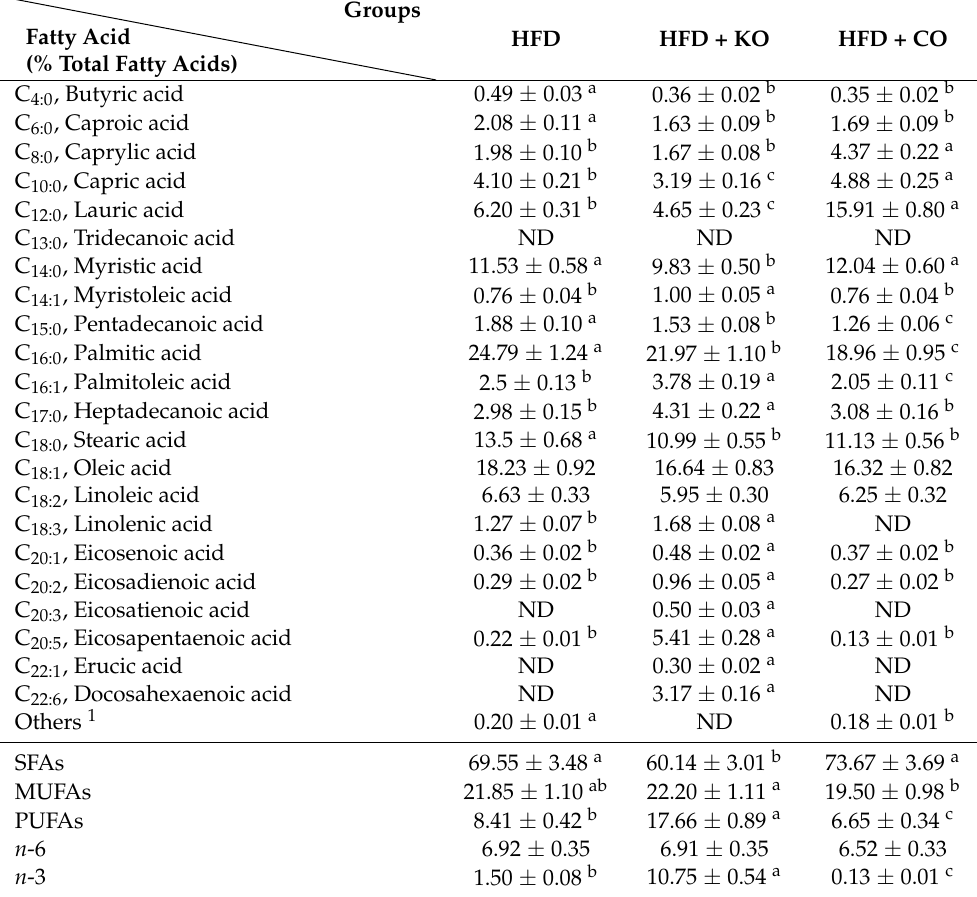
Table 2. Fatty acid composition of the experimental